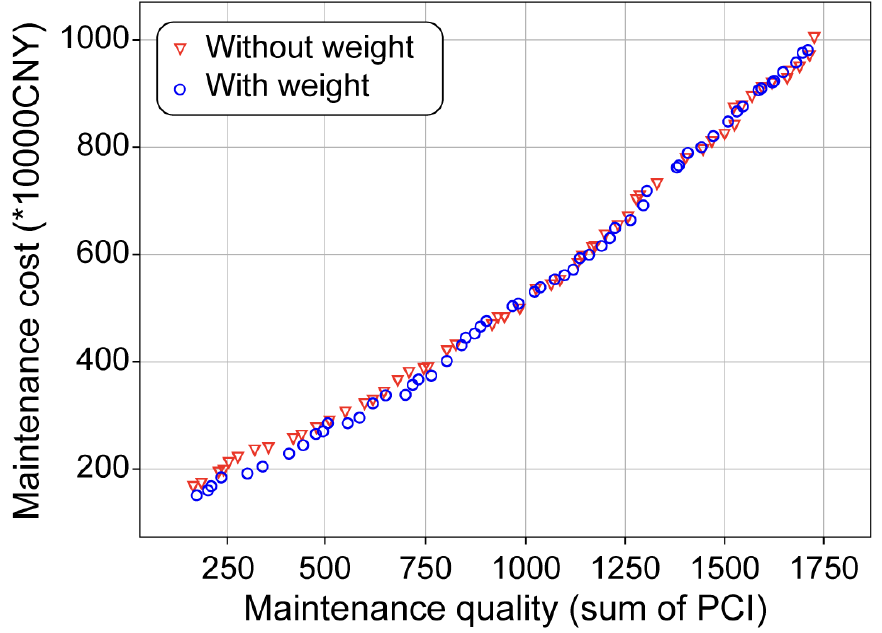
Figure 4. Comparison between the pavement condition index (PCI) values of the roads before and after maintenance calculated by the MBMMQ model.